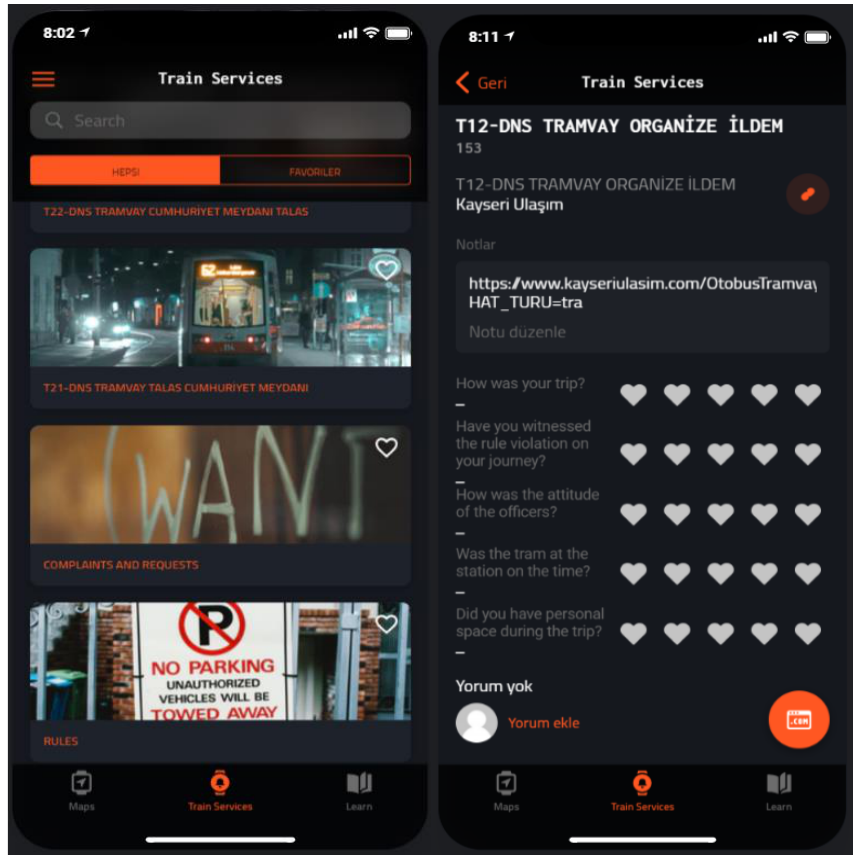
Figure 12 Screens of the application showing the travel query questions (Sedanur